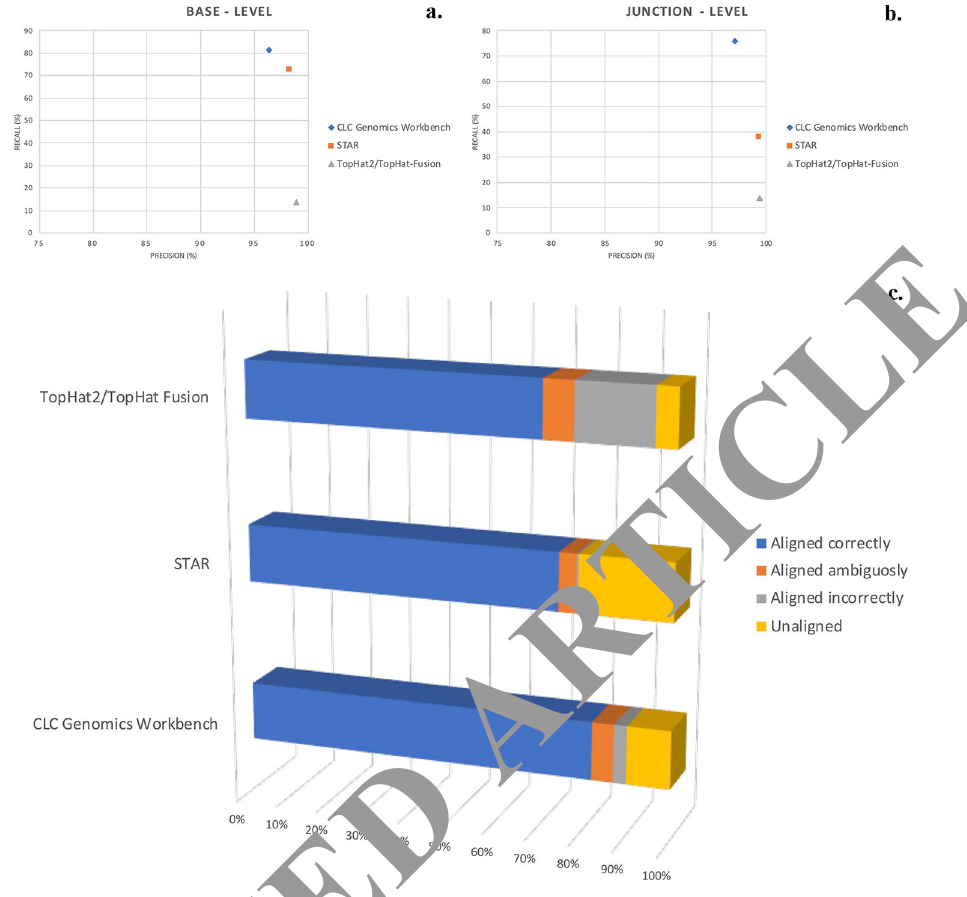
Figure 1. Alignment algorithm comparisons. Exploited alignment algorithms showed significant differences in several parameters. The most important are recall, which measures the fraction of all bases that were aligned correctly, and precision, which determines the fraction of all aligned bases that were aligned correctly. Precision was high for most aligners, while the greatest variance in performance was seen in recall. Both parameters were evaluated at base – ( a ) and junction – level ( b ), in which the “event” considerable right or wrong was each base of each read in the first, and a single read crossing a single splice junction the second. CLC Genomics Workbench algorithm showed the best performance, as confirmed by the highest percentage of correctly aligned reads ( c